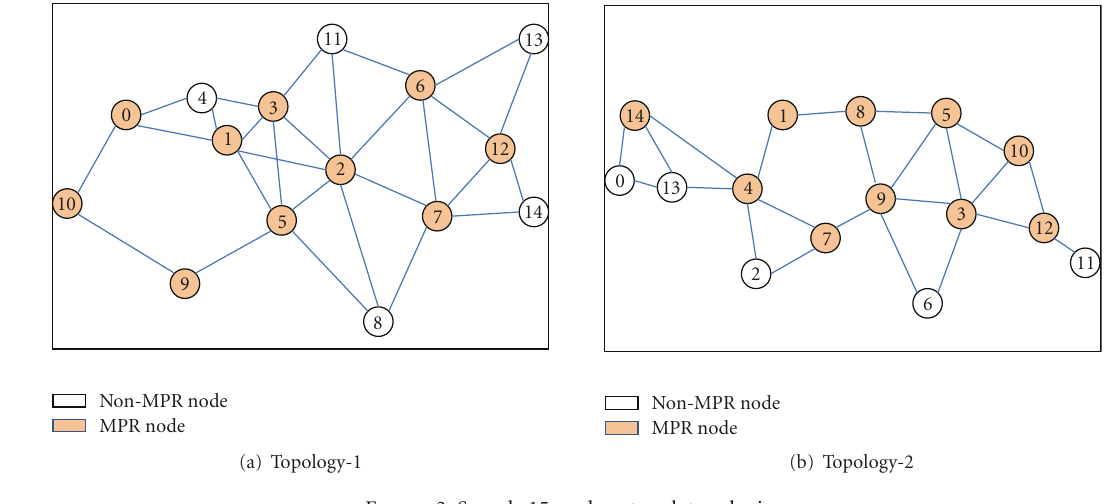
Figure 3: Sample 15-node network topologies.